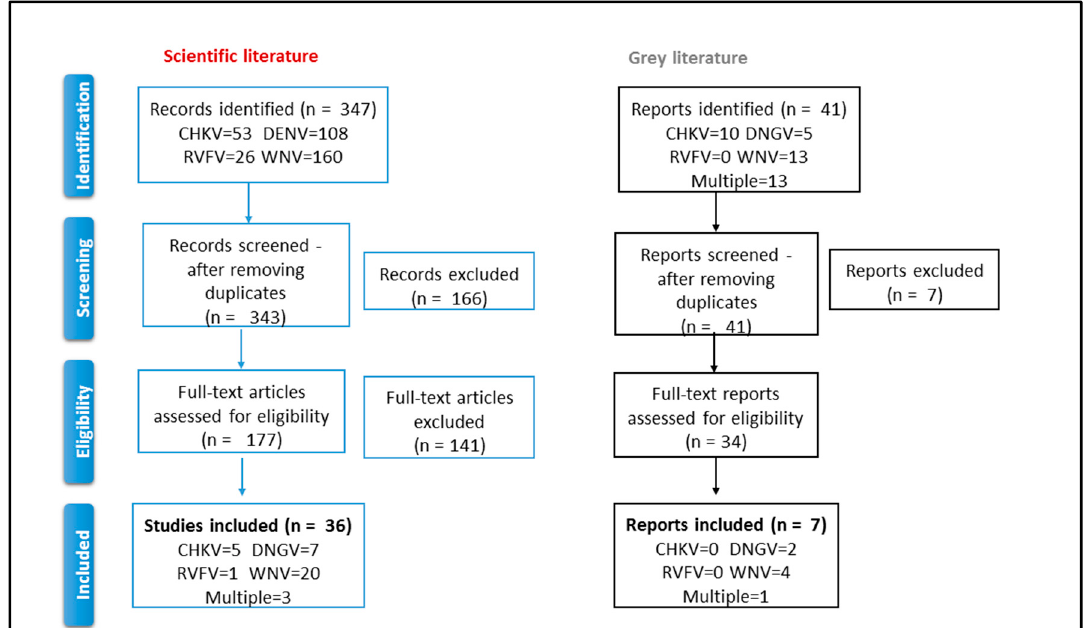
Figure 1. Selection process: identification, screening, eligibility, and inclusion. CHKV = chikungunya virus DENV = dengue virus WNV = West Nile virus RVFV = Rift Valley fever virus.